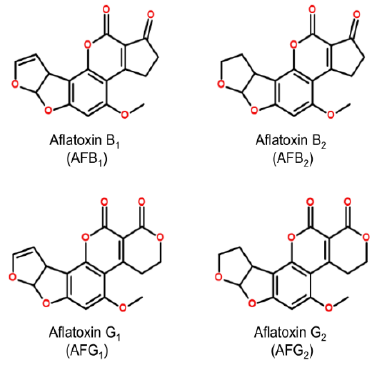
Figure 1. Molecular structures of the four primary aflatoxins.